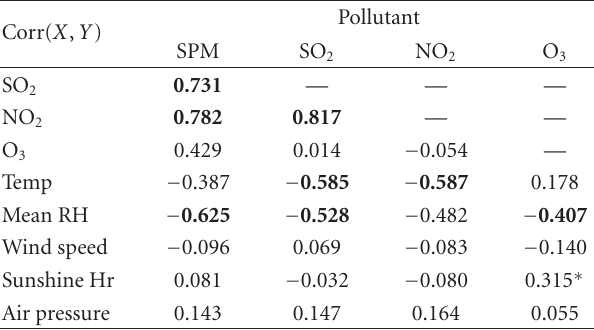
Table 1: Pearson correlation coe ffi cients between selected parame- ters.